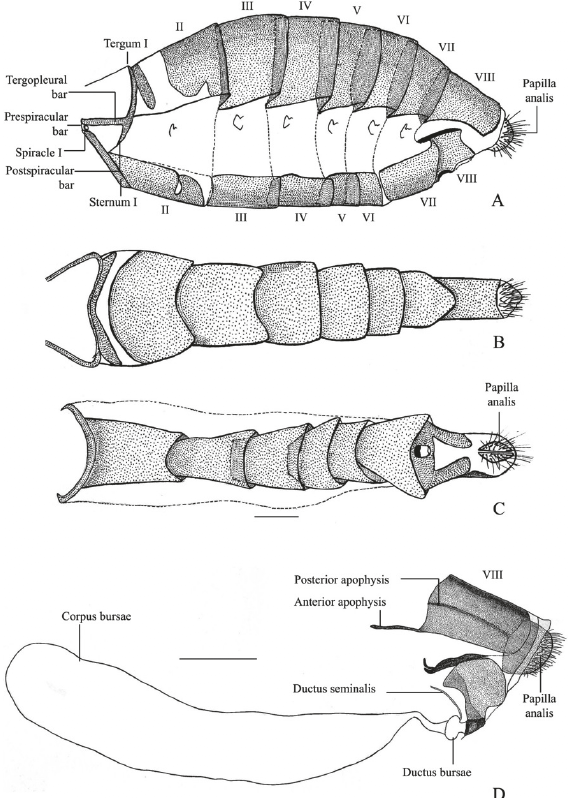
Figure 3. Female genitalia of Junonia orithya (Linnaeus, 1758) A – C - abdomen (lateral, dorsal and ventral view); D - female genitalia (lateral view). Scale bar